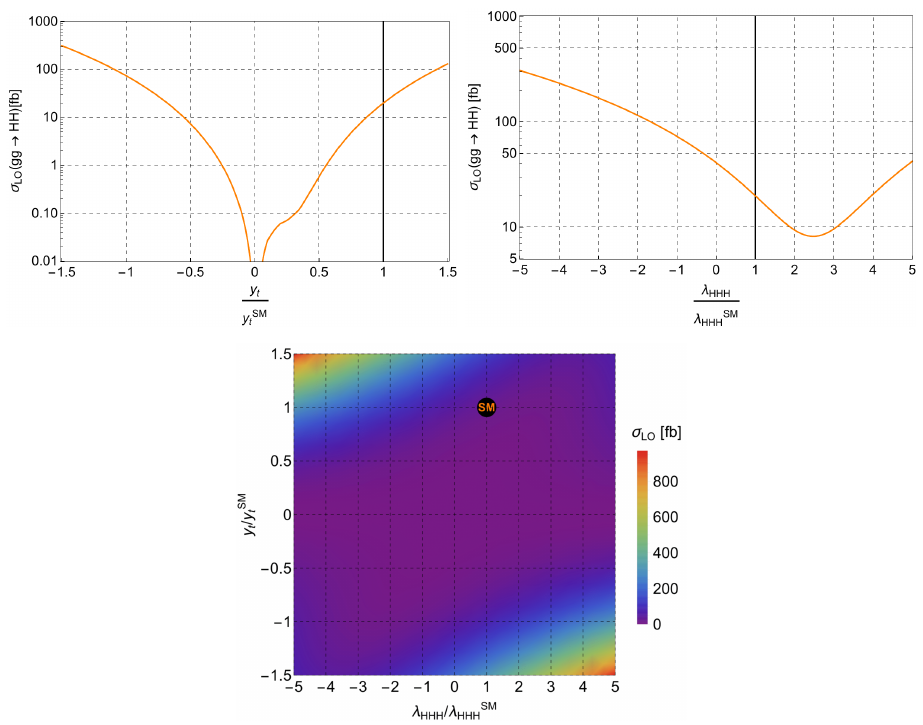
√ Figure 2 . Leading-order SM Higgs pair production in gluon fusion at s = 14 TeV as function of the Higgs top-Yukawa coupling y normalized to the SM value y SM for the trilinear coupling fixed t t to the SM value (upper left); as a function of the trilinear coupling λ normalized to the SM HHH value λ SM for the top Yukawa coupling fixed to the SM value (upper right); as a function of the HHH trilinear and the top-Yukawa couplings in terms of the respective SM values (lower). The color code indicates the size of the LO cross section in fb. The SM point is marked in